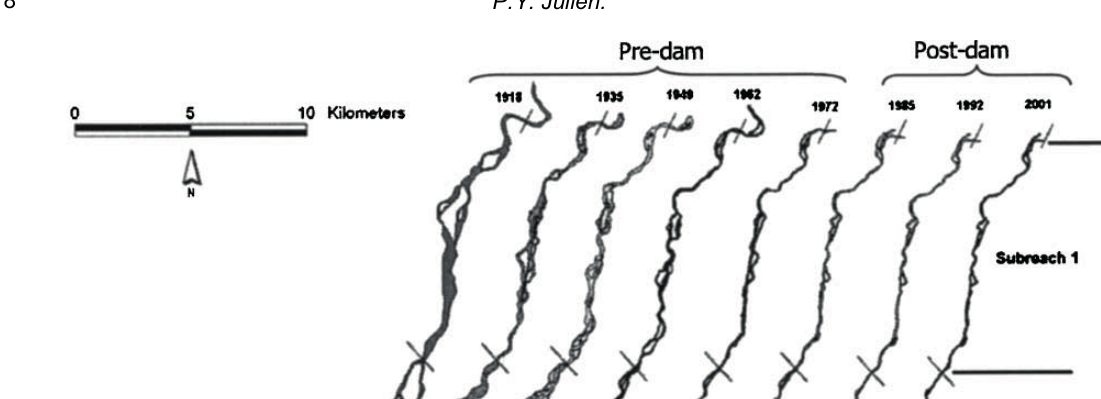
Fig. 3 Changes in channel morphology of the Rio Grande below Cochiti Dam from 1918-2001 from Richard et al. (2005a,b).